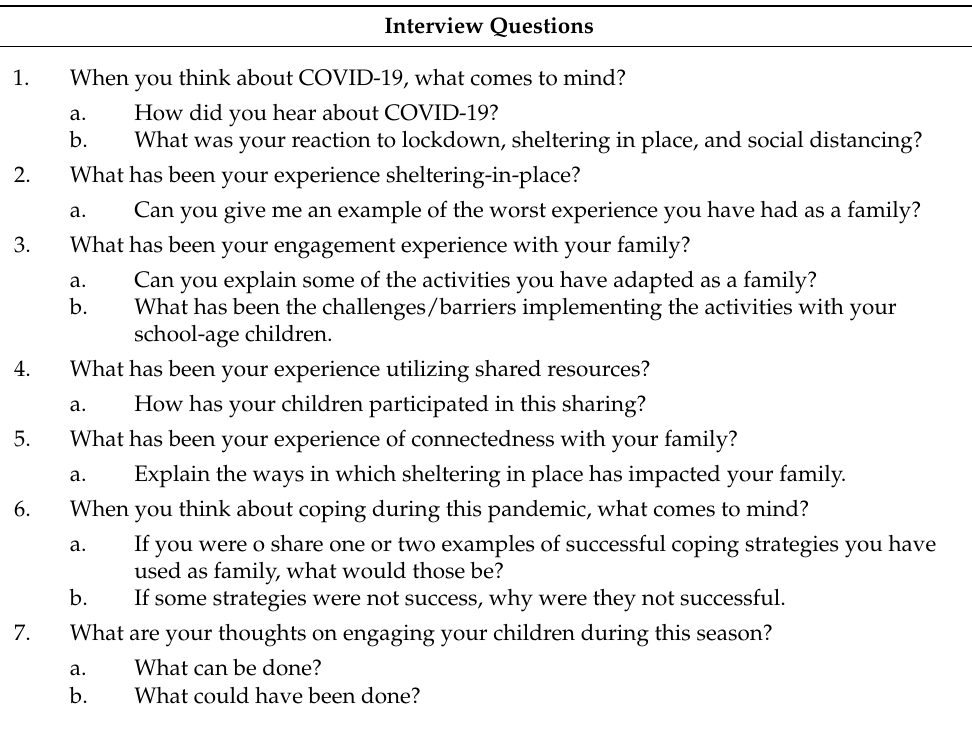
Table 2. Semi-structured interview guide for community health